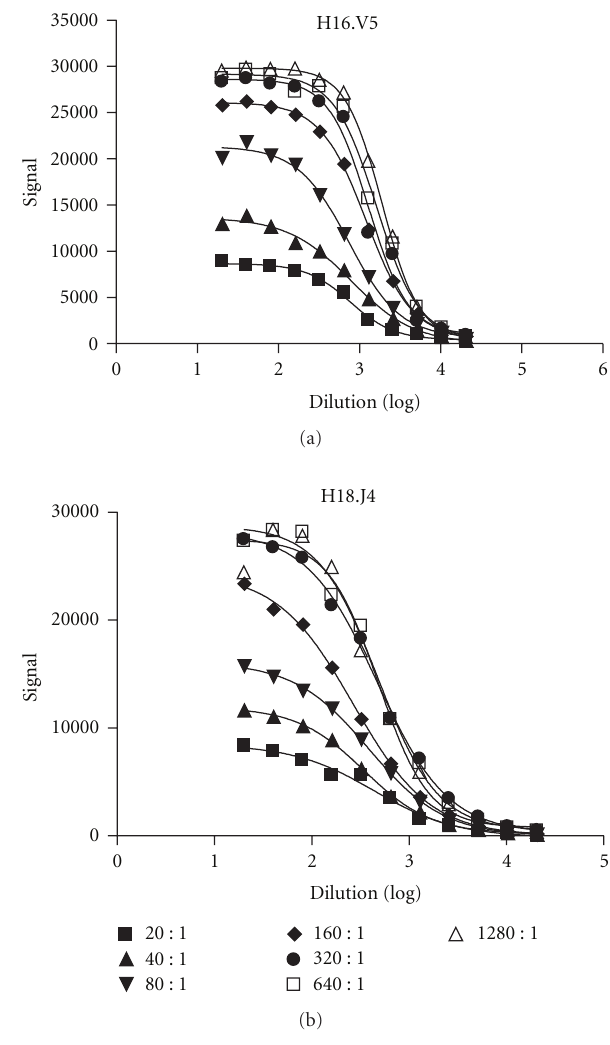
Figure 2: Coupling ratio optimization for neutralizing mAbs biotinylation. (a) H16.V5 biotinylation. (b) H18.J4